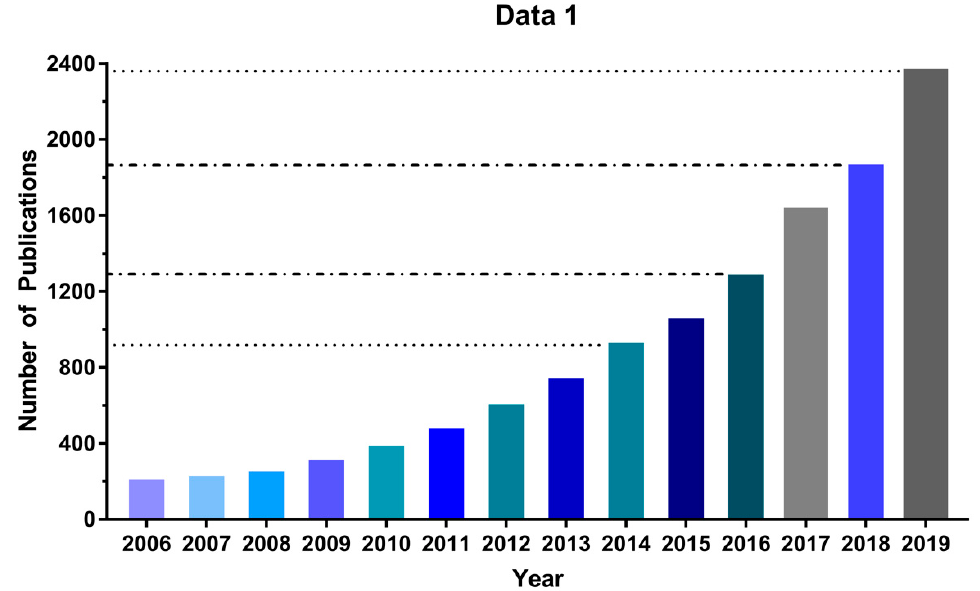
Figure 1. The number of publications per year using MTT assay in photodynamic therapy (PDT) studies. Source: Google Scholar, keywords: MTT assay “photodynamic therapy”.